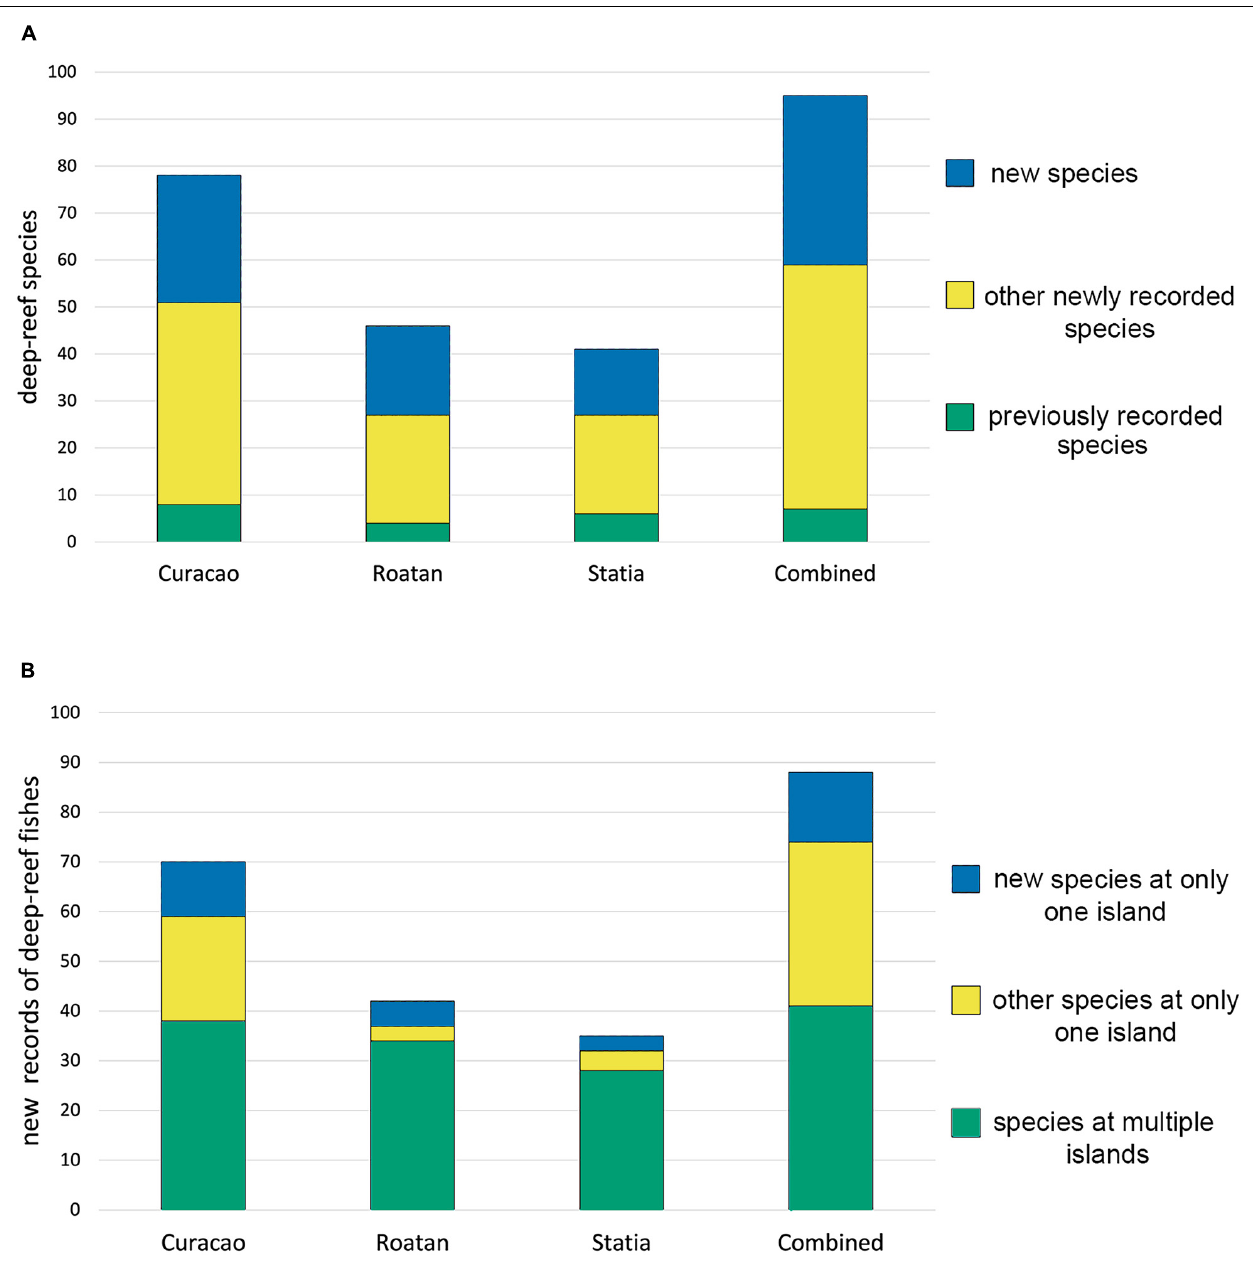
FIGURE 3 | Contribution of DROP submersible research to knowledge of the deep-reef faunas at three sites. (A) Numbers of species recorded by DROP that were not recorded by other research, and the number of those that are new (i.e., previously unknown) species. (B) Percent of new and already named species present at only one of the three islands vs. those at multiple